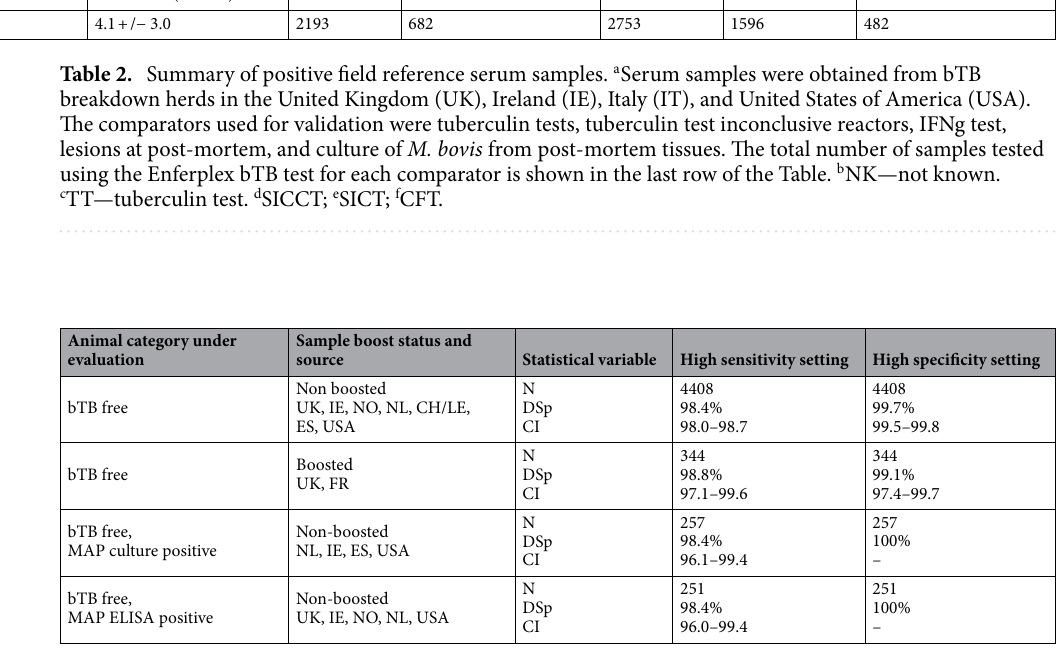
Table 3. Diagnostic specificity estimates of the Enferplex Bovine TB antibody test. Diagnostic specificity was estimated at the high sensitivity and high specificity settings using reference sera from bTB free animals with and without tuberculin boosting and with and without MAP infection. Boosted- samples taken within anamnestic window; non-boosted—samples taken out with the anamnestic window (5–30 days post tuberculin injection). N = number of samples; DSp—diagnostic specificity; CI—95% Confidence